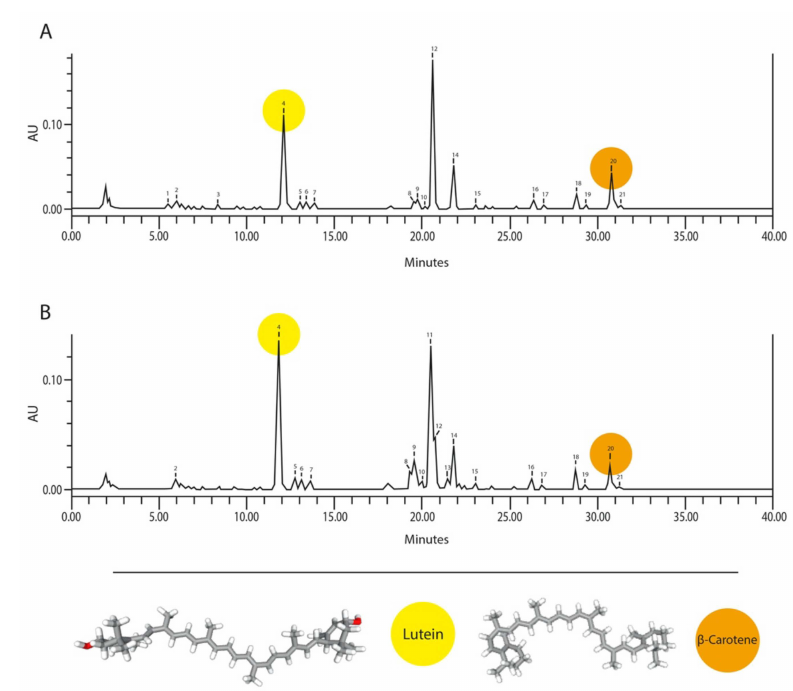
Figure 2. Carotenoid and chlorophyll profiles of methanol extracts of wild B. monnieri from different environments: BH ( A ) and BX ( B ). HPLC-PDA recorded at 450 nm. β -Carotene derivative (1, 5–7), Violaxanthin derivative (2–3), Chlorophyll b derivative (8–10, 14), Unidentified chlorophyll (12–13, 16–19), Lutein (peak number 4, yellow circle), Chlorophyll b (11), Chlorophyll a (15), β -Carotene (peak number 20, orange circle) and 13-cis- β -Carotene (21). The chemical structure model of Lutein and β -Carotene were taken from PubChem,